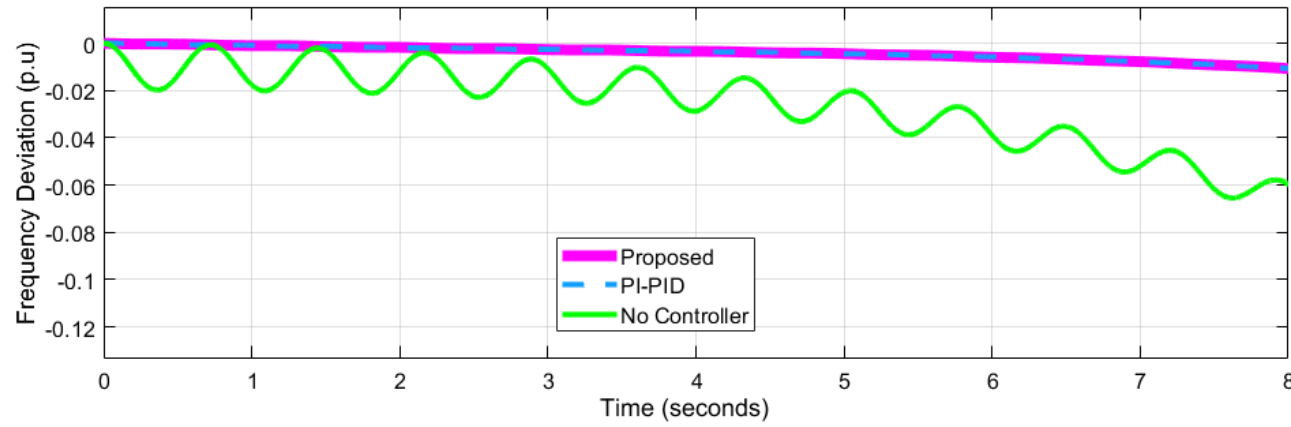
Figure 11. Case 1: frequency deviation at (K p = −1.9111, K i = −0.0080) for network 3.